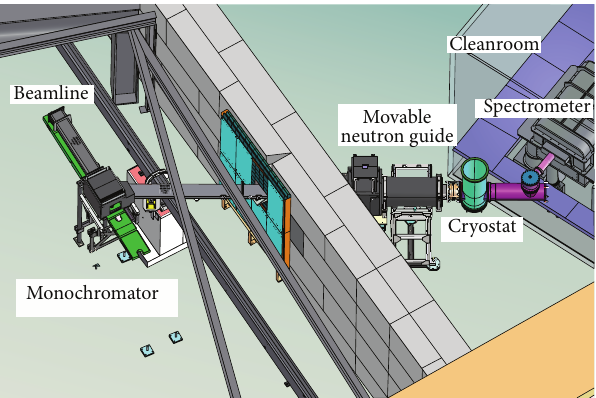
Figure 1: The GRANIT instrument at Level C of ILL, Grenoble.